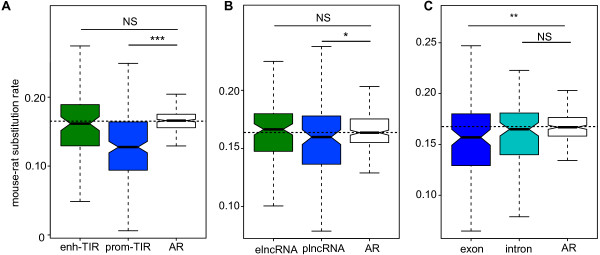
plncRNA but not elncRNA loci are selectively constrained over rodent evolution. (A) Mouse-rat nucleotide substitution rate for elncRNA TIRs (median delncRNA-TIR = 0.161, green) and plncRNA TIRs (median dplncRNA-TIR = 0.127, blue), and for neighboring putatively neutrally evolving sequence (ancestral repeats (ARs), white). Horizontal dashed line represents the neutral expectation (median dAR = 0.165). (B) Mouse-rat nucleotide substitution rate for elncRNA loci (delncRNA-loci = 0.166, green) and plncRNA loci (dplncRNA-loci = 0.159, blue), and ARs (white). (C) Mouse-rat nucleotide substitution rate for transcribed and spliced plncRNA exons (dplncRNA-exon = 0.156, violet) and plncRNA introns (dplncRNA-intron = 0.165, turquoise), and ARs (white). Two-tailed Mann–Whitney test, ***P < 0.001; **P < 0.01; *P < 0.05; NS, not significant.